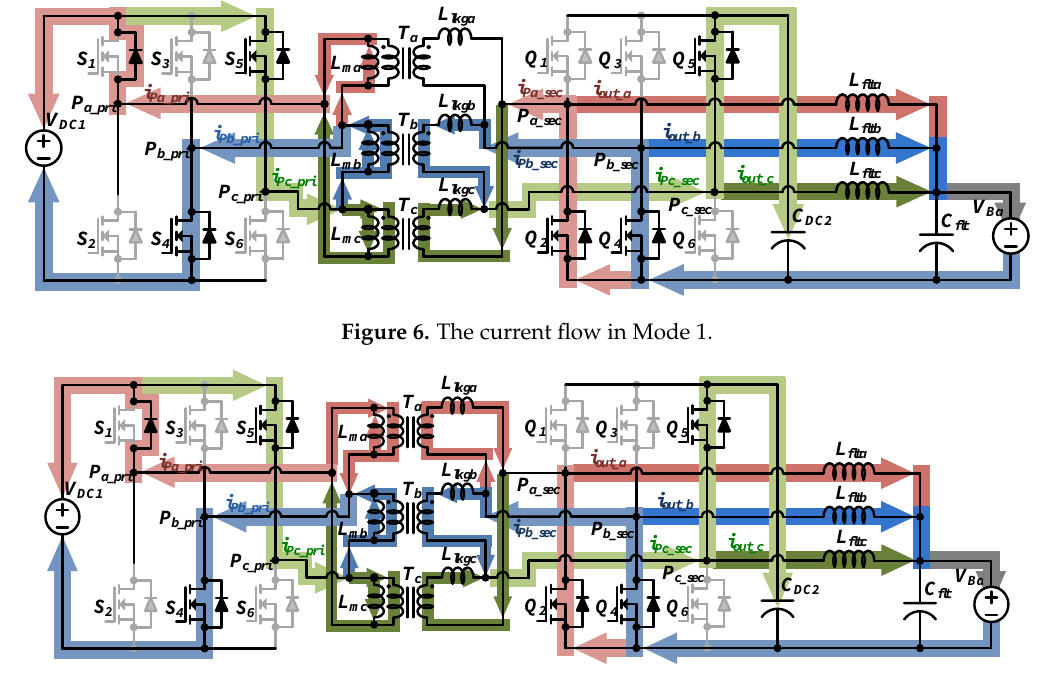
Figure 7. The current flow at the moment when the current i Pa_sec becomes zero.